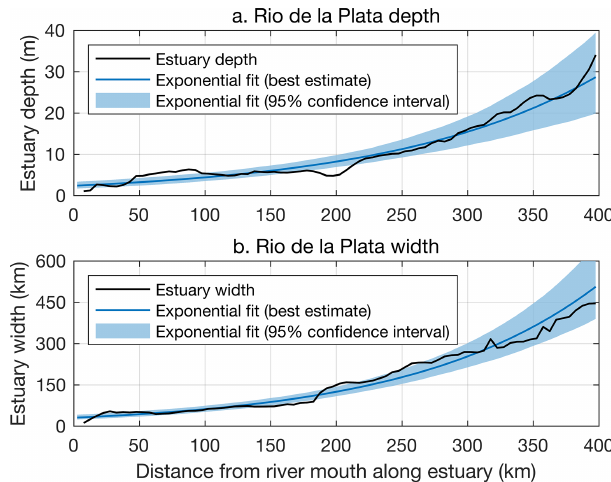
Figure 2. Black curves illustrate the (a) average depth and (b) width of the Río de la Plata as a function of distance along the estuary from the river mouth based on the GEBCO 2021 grid (GEBCO Compi- lation Group, 2021). Values are determined by identifying all ma- rine grid cells (depths < 0) in successive 5km increments from the river mouth. The average depth is computed as the arithmetic mean of all grid cell depths, and the width is defined as the maximum distance between the marine grid cells within the given 5km incre- ment. Dark blue curves and light blue shading represent best esti- mates and 95% confidence intervals, respectively, of exponentials fit to the black curves using ordinary least squares. To account for residual autocorrelation, the uncertainties are based on the effective degrees of freedom assuming residuals are described by an order-1 autoregressive